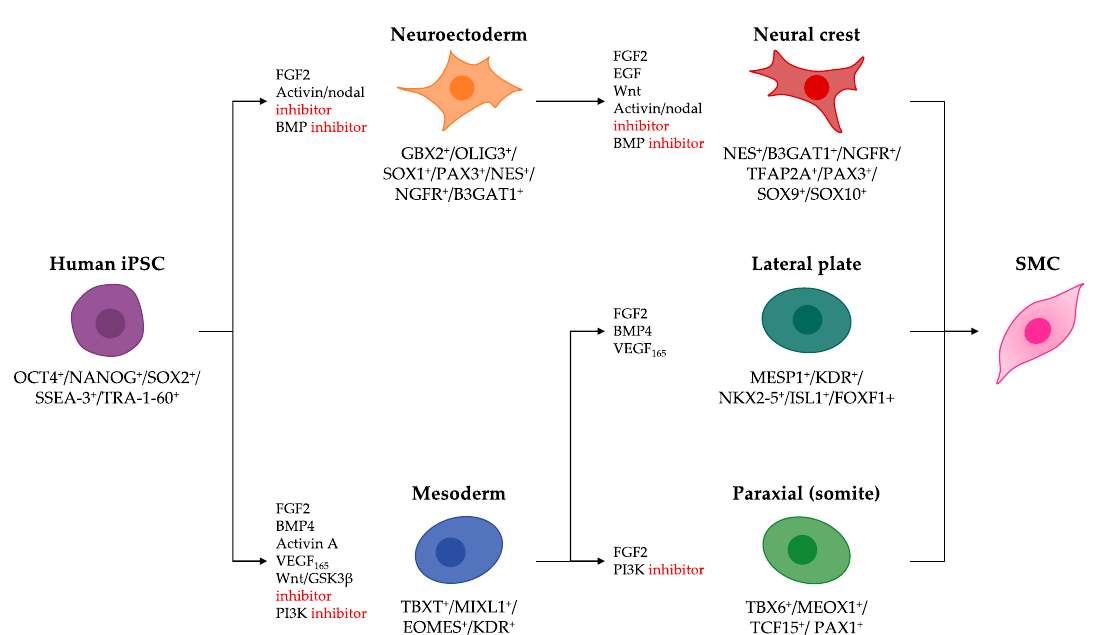
Figure 3. Proposed strategies to derive lineage-specific SMC intermediates from hiPSCs. Derivation of lineage-specific SMC intermediates from hiPSCs recapitulates the defining events of early embryonic development and cell lineage specification in vertebrate embryos. Combinations of growth factors, cytokines and phenotypic markers that define each cell type are listed.